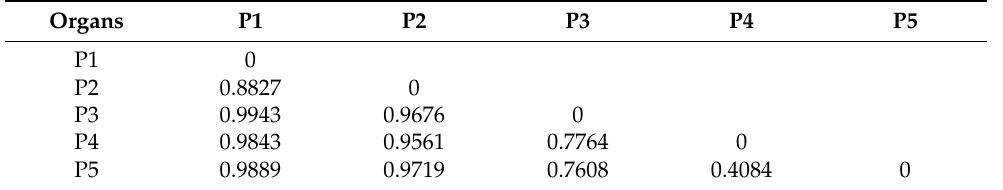
Table 4. Bray − Curtis dissimilarity index among five floral organs in L. caudata .